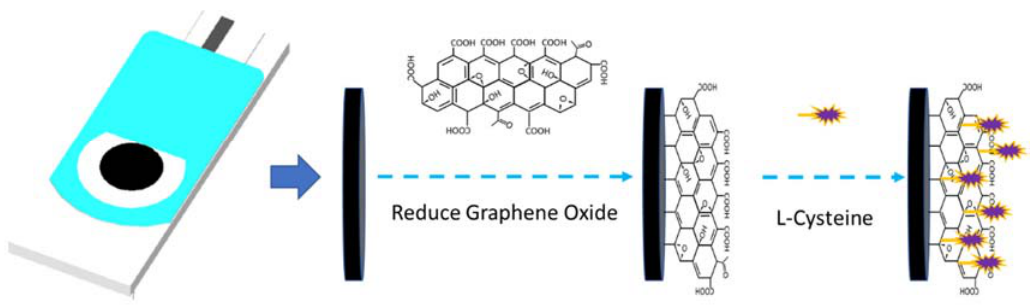
oxide and Figure 1. The process of a disposable screen ‐ printed electrode (DSPE) modified to reduce graphene oxide and L ‐ cysteine.